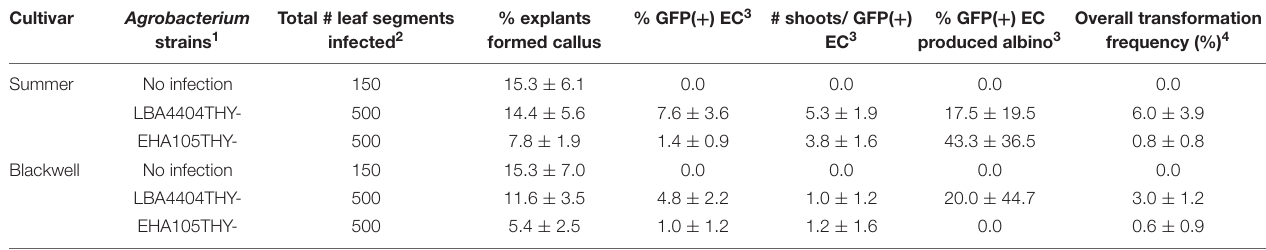
TABLE 2 | Summary of transformation experiments using two Agrobacterium strains.